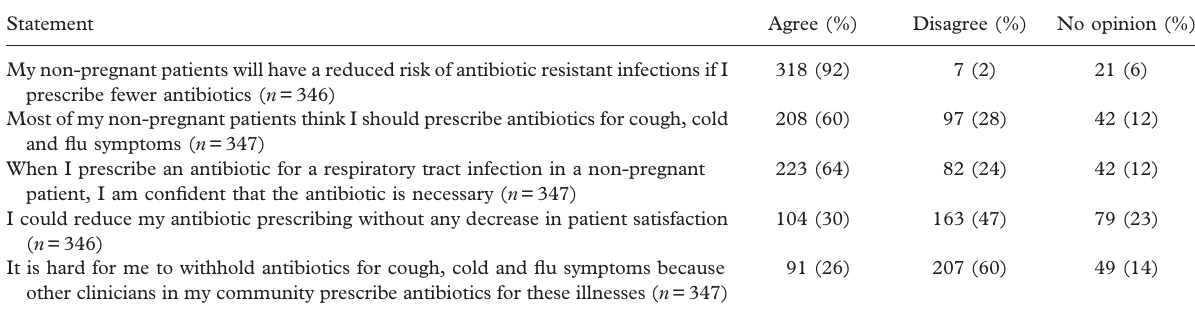
Table III. *Distribution of responses to knowledge and attitude questions regarding treatment of URI in non-pregnant patients among OB/ GYNs.